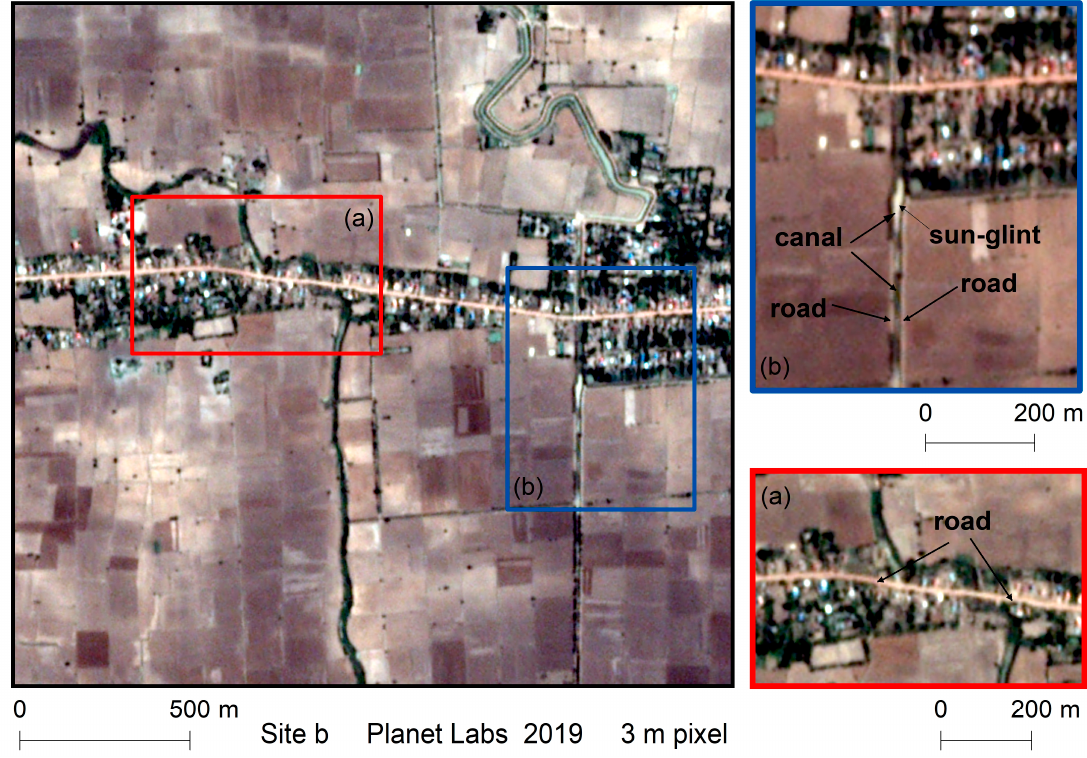
Figure 11. Modern imagery of the Banteay Meanchey Site b. Planet Labs imagery 3 m resolution. Red ( a ) and blue ( b ) insets provide closer view of canals and roads at the site.